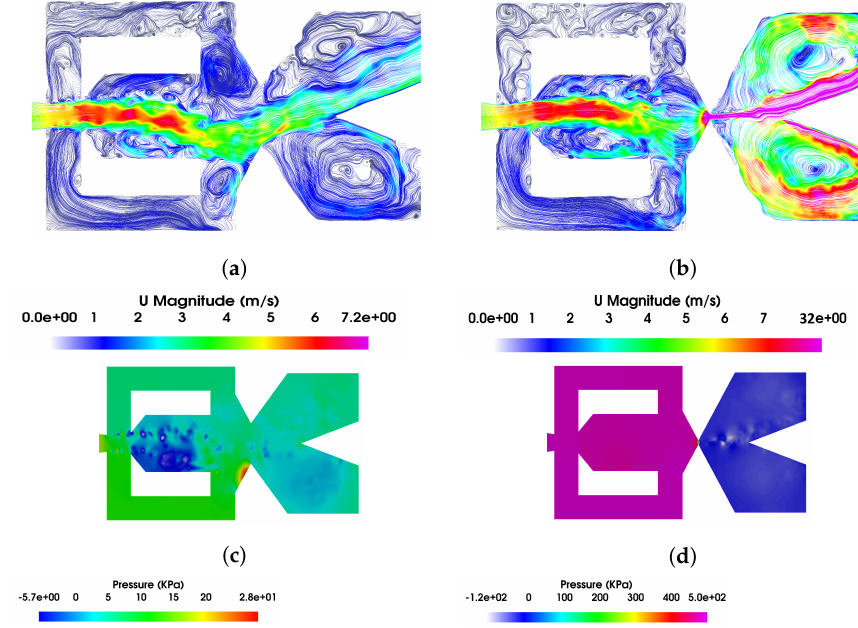
Figure 8. Fluidic oscillator internal velocity field ( a , b ) and pressure magnitude ( c , d ). Maximum outlet width ( a , c ), minimum outlet width ( b , d ). Reynolds number